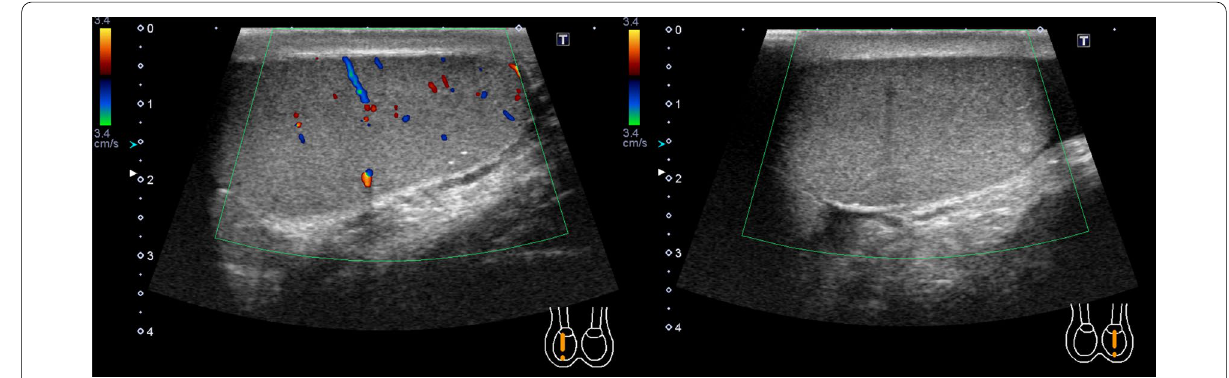
Fig. 1 Ultrasound findings. Surface ultrasound scan of the scrotum showed absence of blood flow in the left testis. This finding was suggestive of left testicular